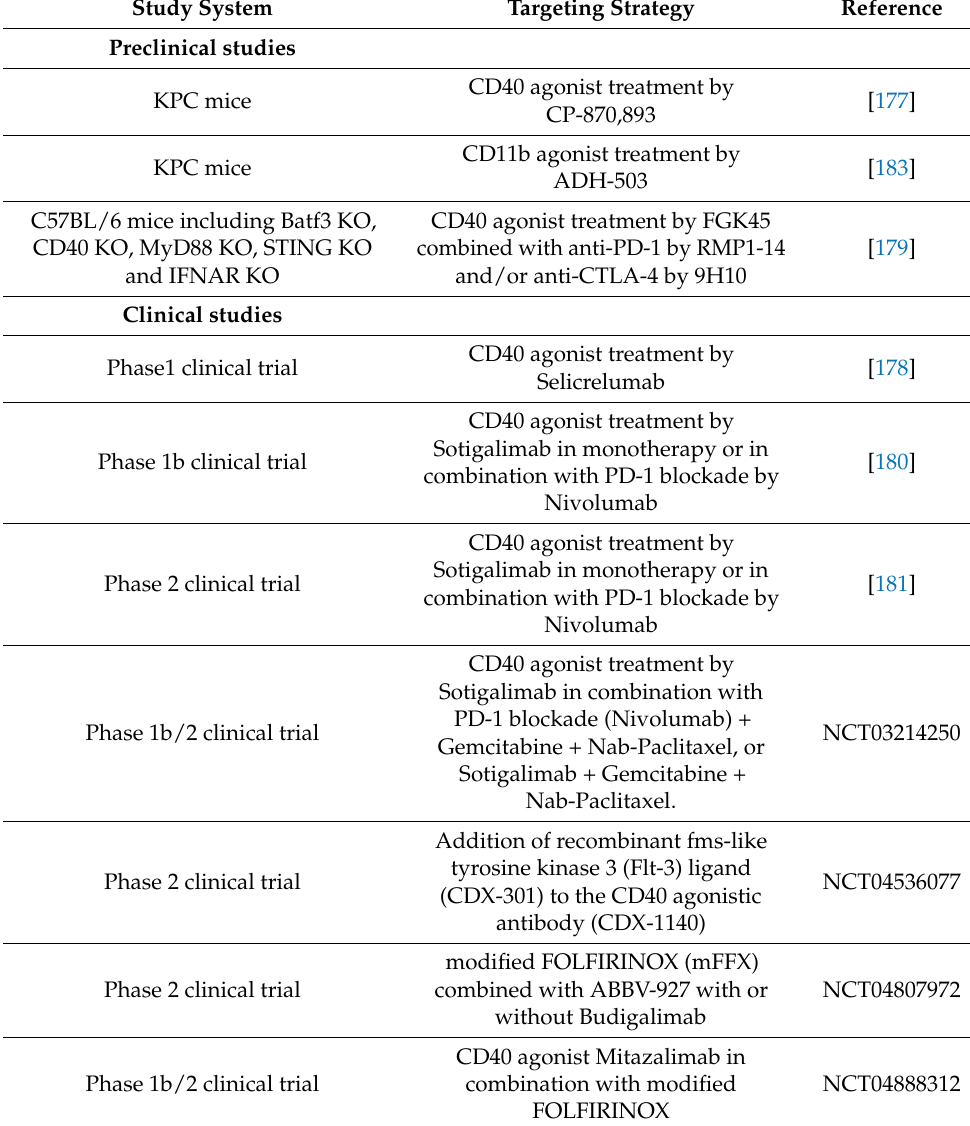
Table 2. Overview of the cited therapeutic approaches targeting